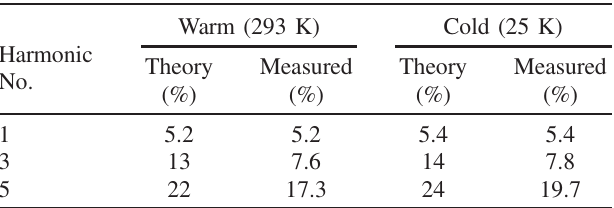
TABLE IV. Bandwidth of the UR measured with the trans- mission grating spectrometer. The fundamental is measured with a spectrometer ’ s slit widths of 75 μ m and 100 μ m (warm and cold, respectively), the higher order bandwidths with 50 μ m slit widths for both temperatures. The bandwidth of the higher harmonics is overestimated by the theory (diffraction) — see appendix for